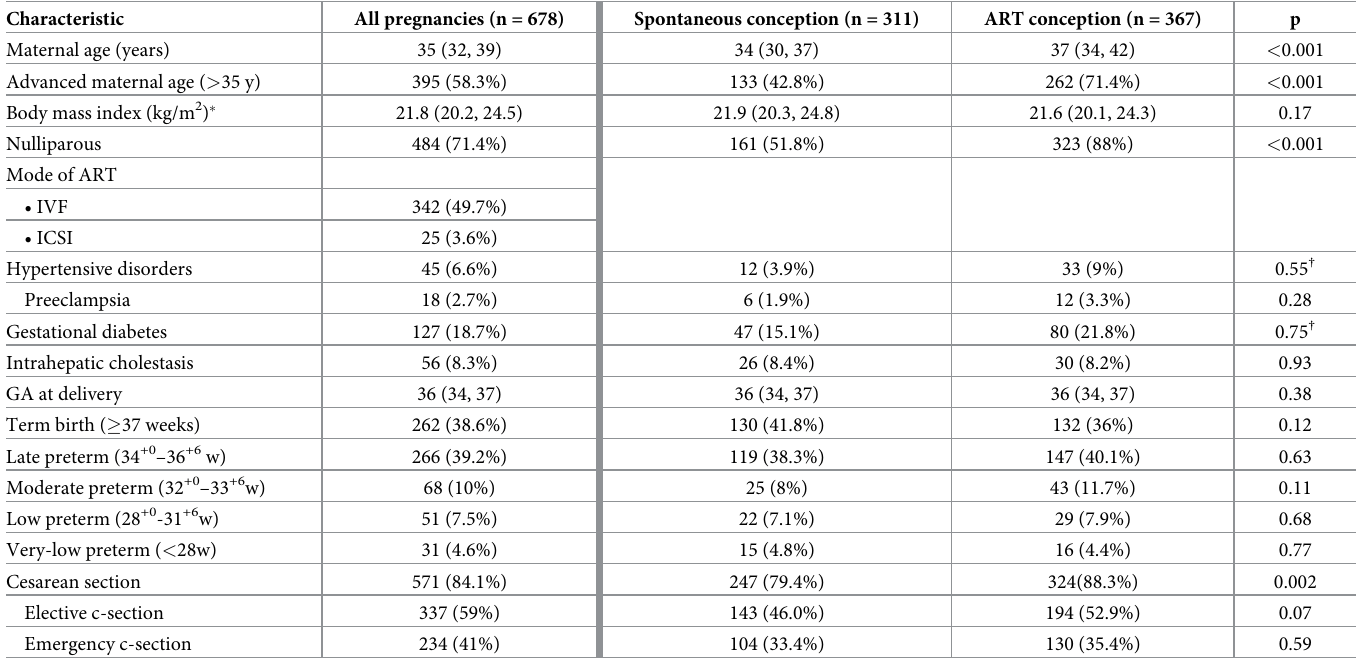
Table 2. Maternal characteristics and pregnancy outcome according to mode of